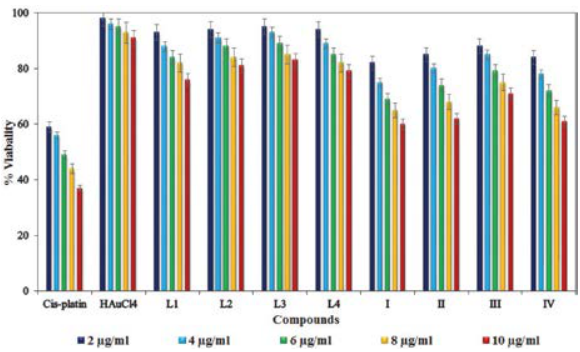
Figure 6. S. pombe cell viability represents as the percentage with standard deviation for three independent experiments of synthe- sized compounds.